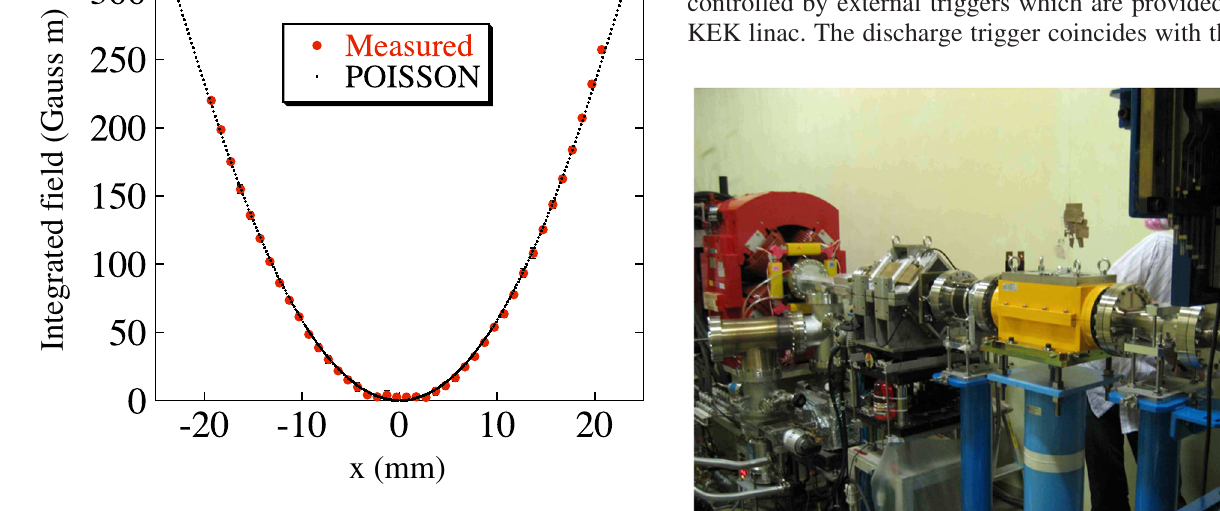
FIG. 15. (Color) Horizontal distribution of the integrated mag- netic field of the PSM. Solid circles (red) show the measured value, and the dotted line (black) shows the calculated result of the POISSON code.